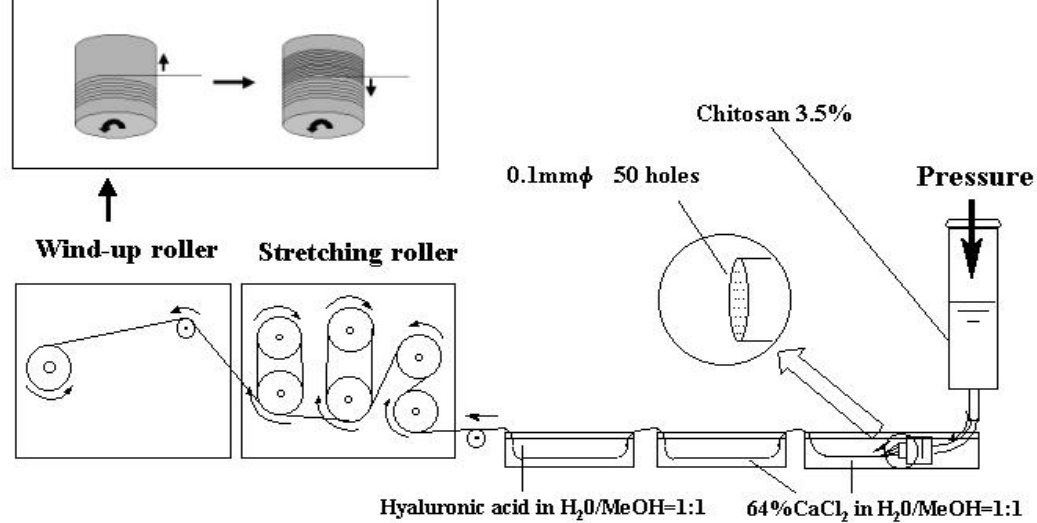
Figure 1. Our original roller system for creating the chitosan-based HA hybrid polymer